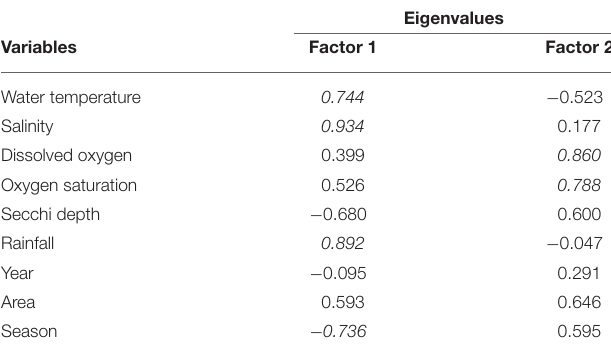
Frontiers in Marine Science |